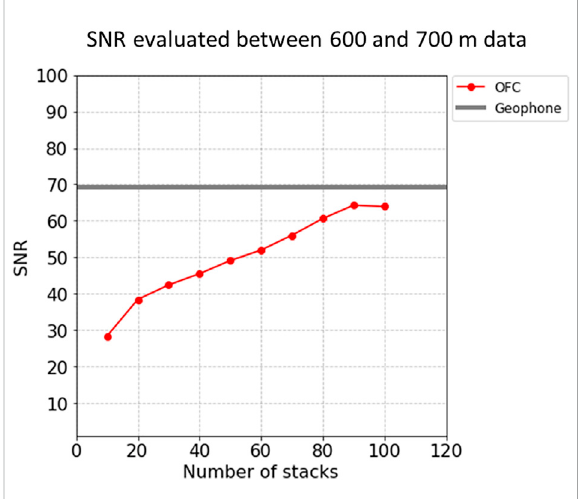
FIGURE 6 Comparison of SNR by geophone and DAS. Geophone data were evaluated by a stack of fi ve sweeps and the effect of stacking to SNR is shown for DAS